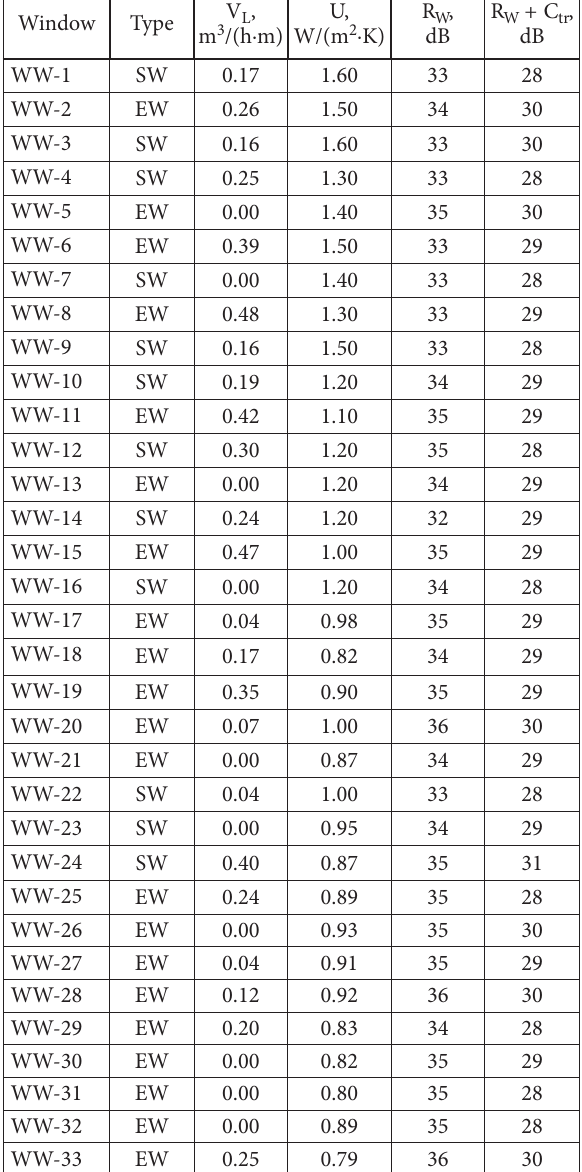
Table 2. Performance of tested windows